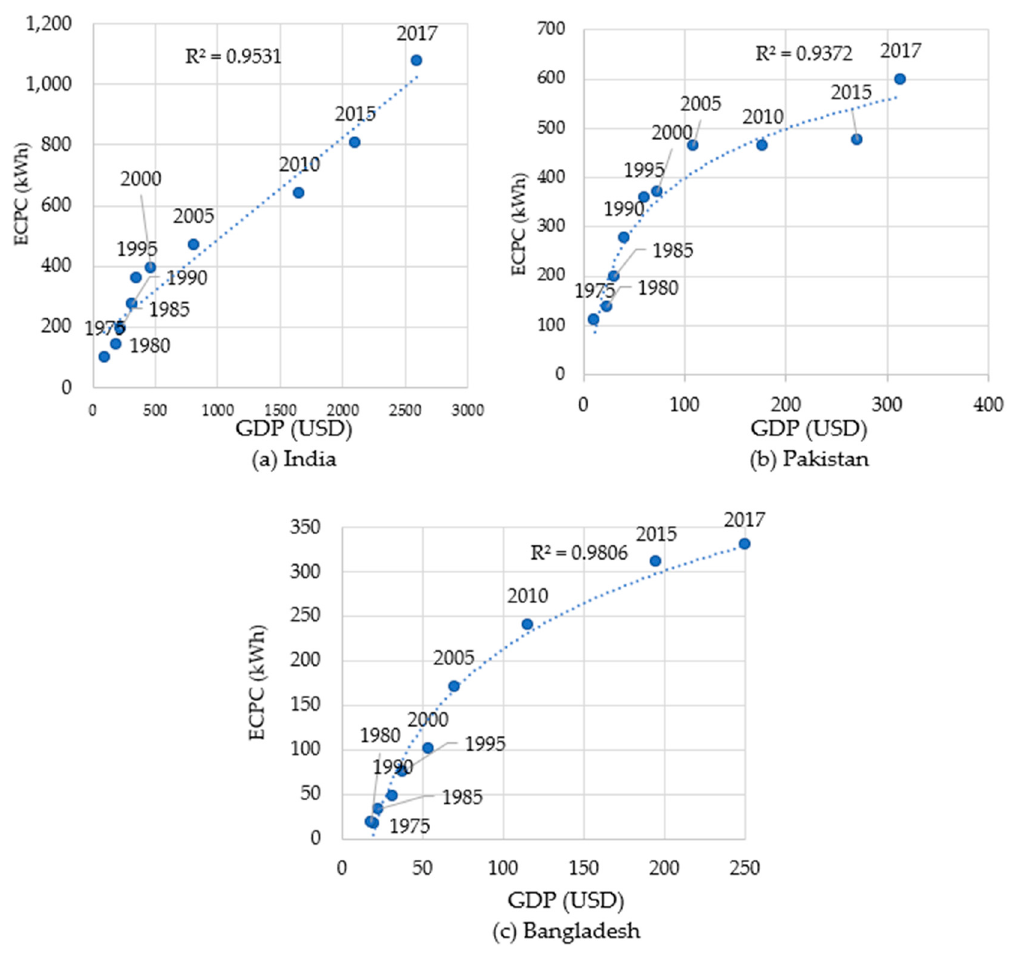
Figure 22. ECPC of IPB vs. GDP shows a logarithmic relationship between ECPC and GDP of Bangladesh and Pakistan, while the relation for India has been observed linear.